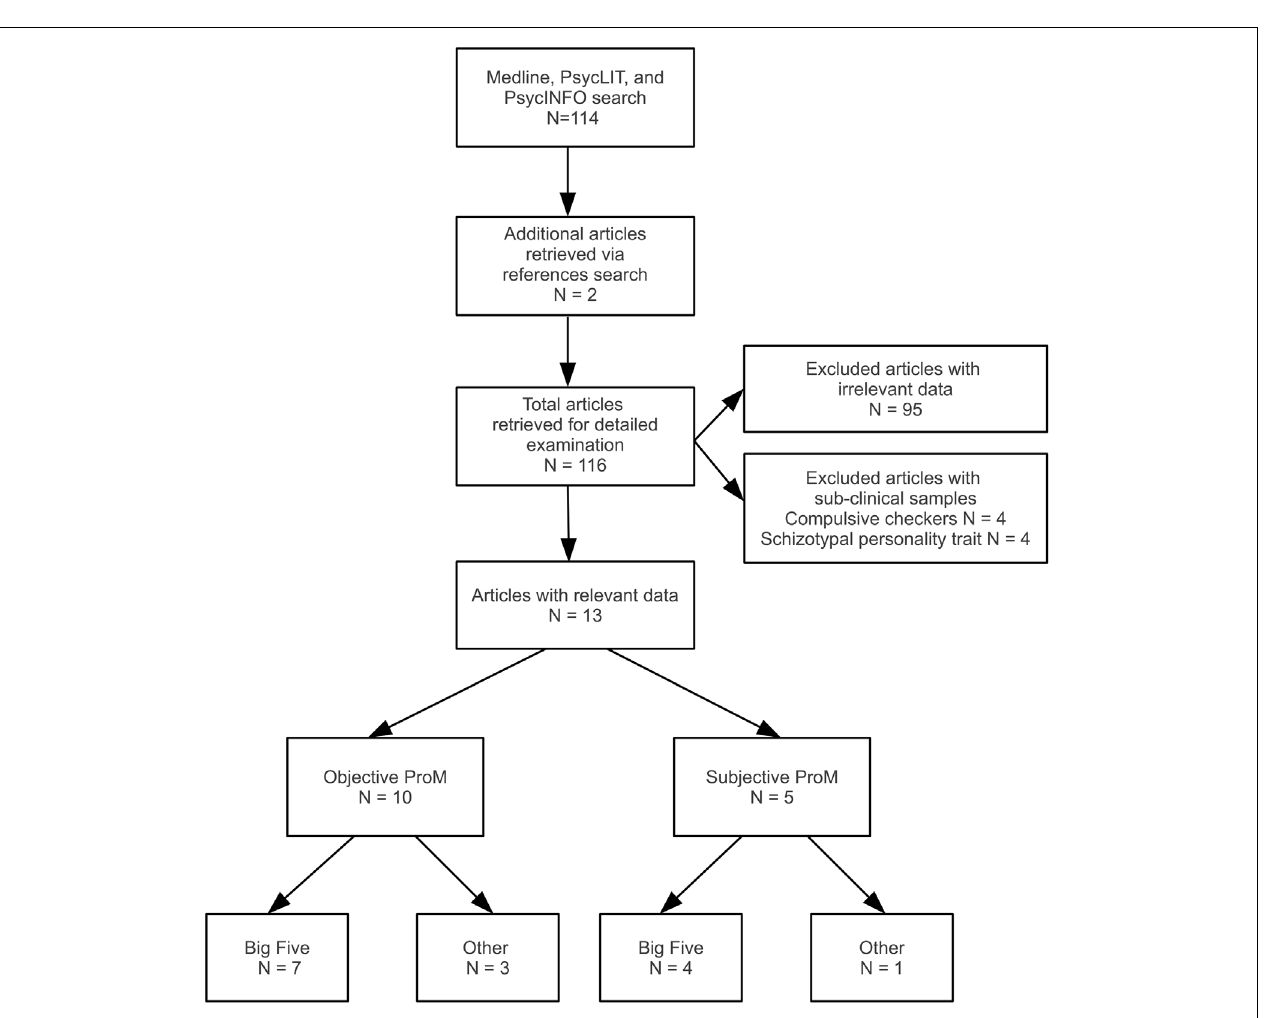
FIGURE 1 | Flowchart of the search strategy and selection of studies included in the review and meta-analysis.